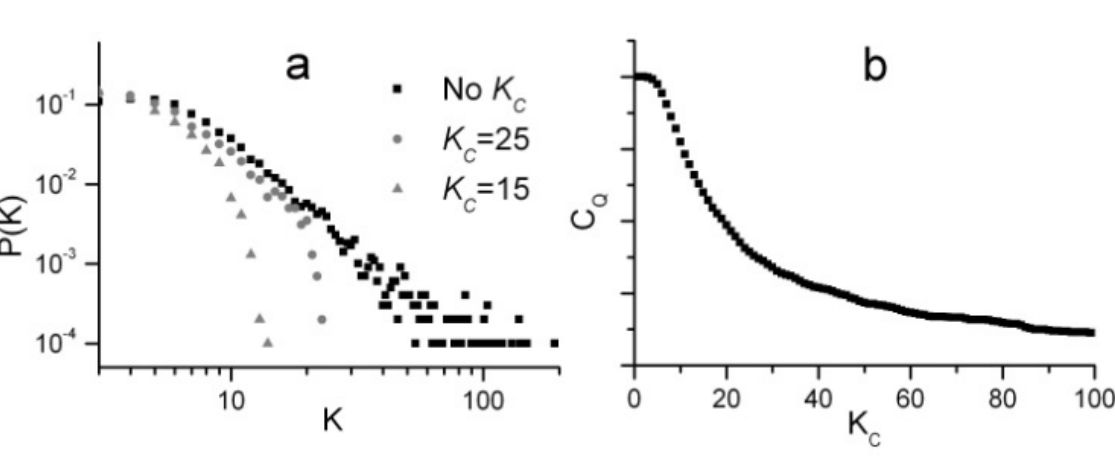
Figure 2: (a) The degree distribution of the network P ( K ) for a given K C = 15 and 25 . (b) A small K C presents highly strengthened measures being practiced, so that social activity is depressed and great economic losses C Q will be